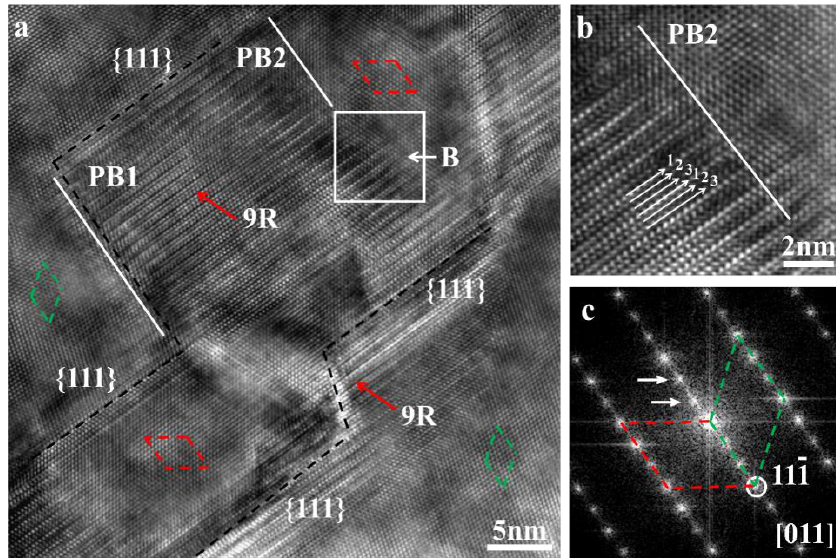
Figure 2. The 9R is located at the turning of discontinuous twin boundaries. ( a ) High-resolution transmission electron microscopy (HRTEM) image of region R1 in Figure 1c; ( b ) The magnification image of the white square B; ( c ) The corresponding Fourier transformation (FFT) pattern of Figure 2a. The 9R is also observed at the intersection of multiple twins in modified eutectic Si, as shown in Figure 4. Figure 4a is the TEM image of multiple twins taken from the region R2 (in Figure 1b) along the [011] zone axis. According to the corresponding FFT pattern (Figure 4b), three groups of diffraction spots can be found and marked by green, red, and blue dash lines, which are named as I,